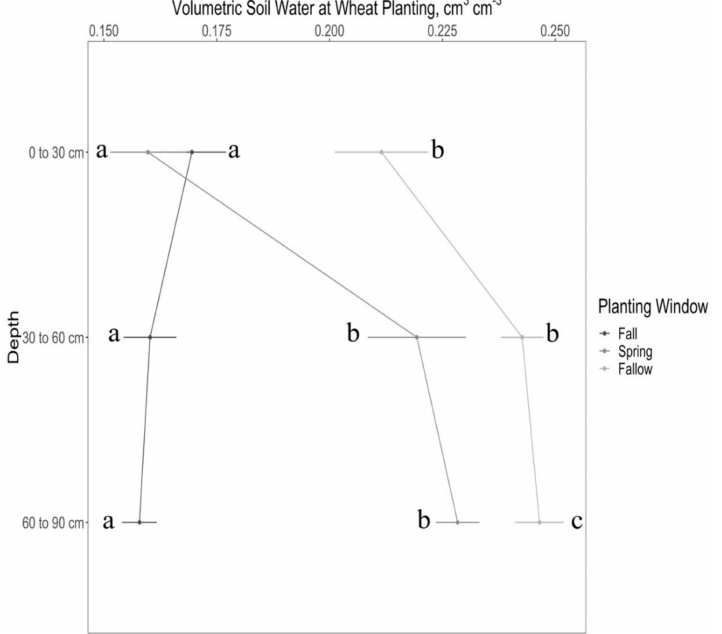
Figure 3. Soil water levels at 2017 wheat planting in a field experiment (T2) located at the Southwest- ern Colorado Research Center in Yellow Jacket, CO. Significance of orthogonal contrasts between spring- and fall-planted cover crop and fallow treatments for each depth are indicated by compact letter display, where groupings differ by an alpha level of 0.05.